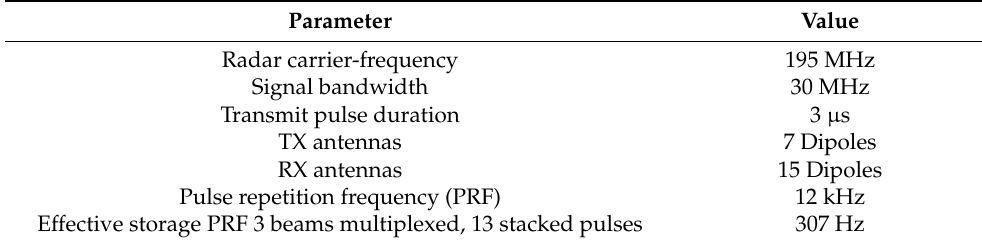
Figure 1. The sites of data acquisition. The Arctic Archipelago is a group of islands along the Canadian Arctic Ocean; the glacial channels in the Arctic Archipelago are usually narrower than 3000 m. Table 1. MCoRDS system parameters.